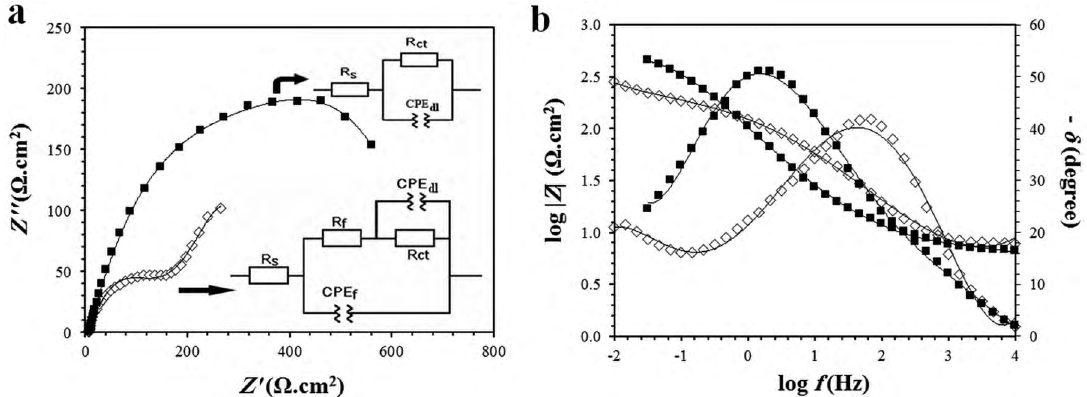
Figure 3. Equivalent electrical circuits used to fit the EIS results. Table 2. Variation of electrochemical parameters of mild steel after 1,4 and 44 h immersion in 3.5 wt. % NaCl solutions. Test